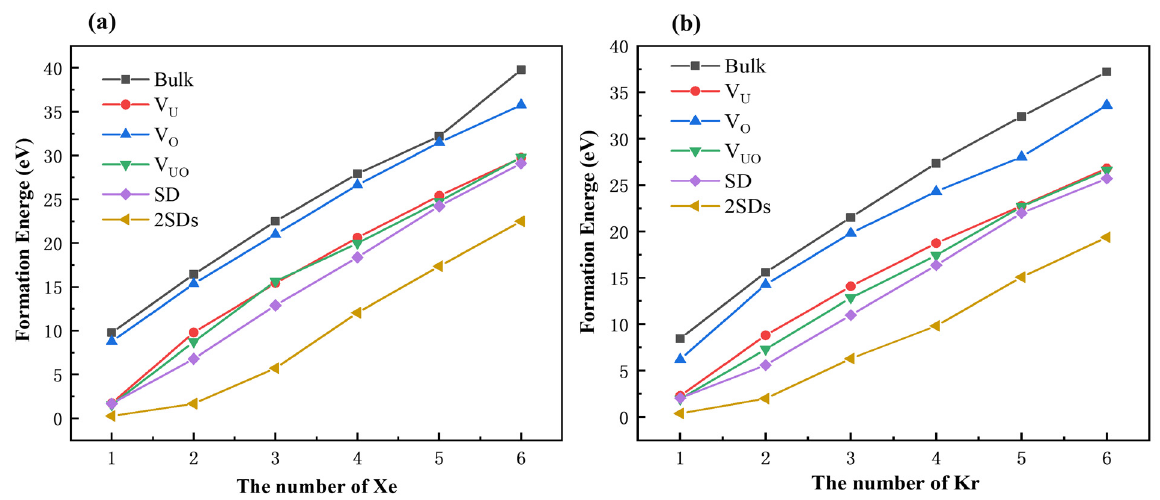
Figure 2. The formation energy (eV) of ( a ) Xe clusters and ( b ) Kr clusters in UO 2 with and without defects as a function of the number of Xe or Kr atoms in the formed cluster.